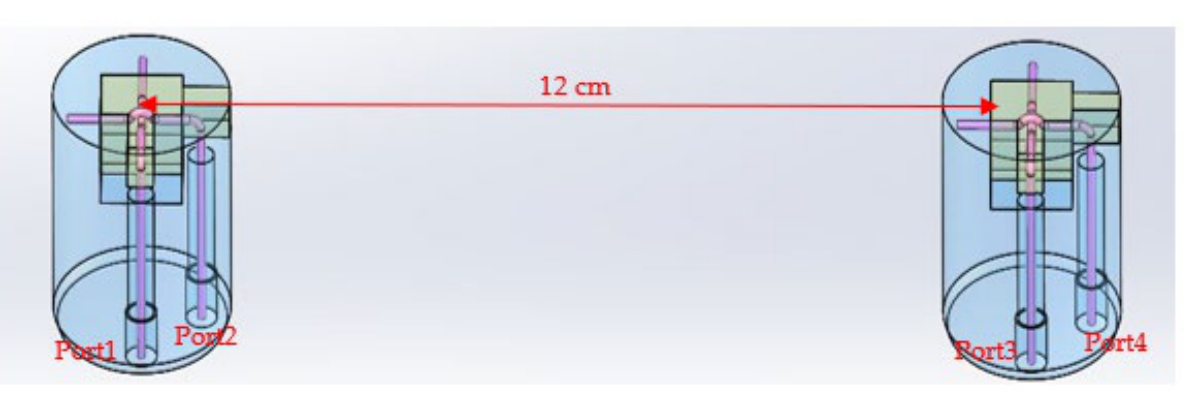
Figure 7. Simulation setup for dual antennas spaced 12 cm apart in water.